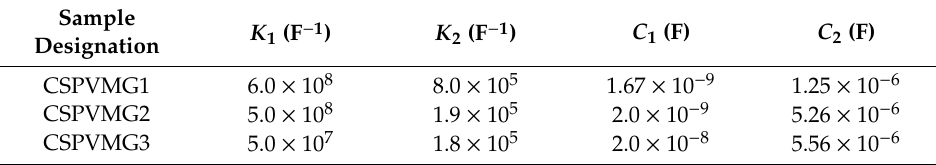
Table 4. The EEC fitting parameters for CPEs system at room